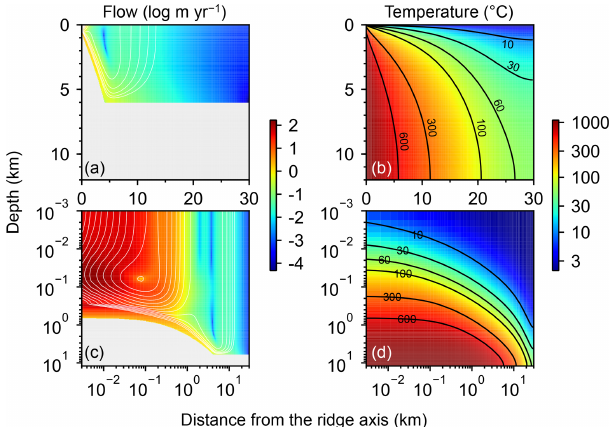
Figure 1. Two-dimensional distributions of hydrothermal fluid flow ( a and c ) and temperature ( b and d ). Shown in (a) and (c) are log- arithms of fluid velocity (myr − 1 ) together with mass-based stream lines that are depicted with white curves. The same data in (a) and (b) are plotted on logarithmic scales in (c) and (d) , respectively. Gray zones in (a) and (c) represent where rocks are impermeable below 6km depth and/or with temperatures above the rock-cracking threshold (600 ◦